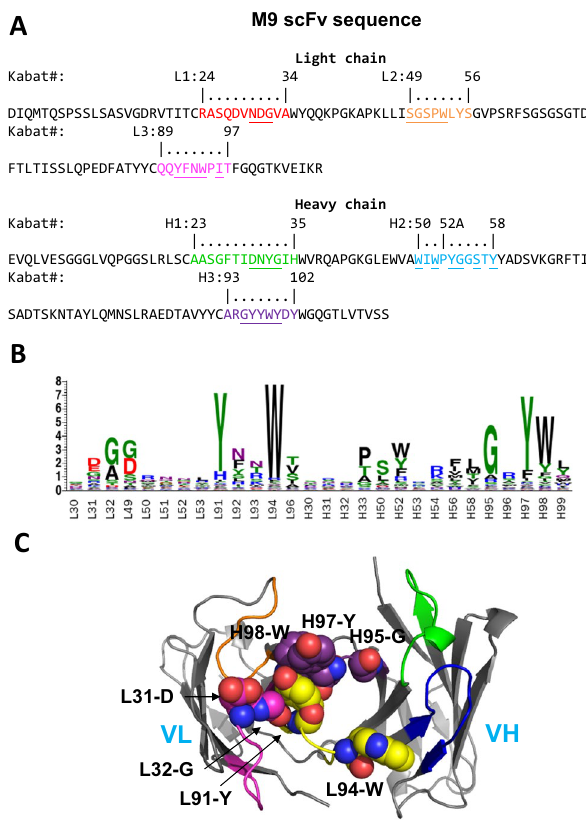
Figure 2. Amino acid sequences of the anti-MSLN M9 antibody variable domains and MSLN-positive scFv CDR-variants of M9 selected from the phage-displayed synthetic antibody libraries based on the methodology depicted in Fig. 1. ( A ) Sequences of the M9 light chain and heavy chain variable domain are labeled with Kabat numbering. The colored regions are the CDRs defined by North et al. 34 . Underlined CDR residues were diversified with degenerated codon NNK in constructing the phage-displayed synthetic antibody libraries in Step 1 of Fig. 1. ( B ) The panel shows the sequence LOGO of the scFv CDR-variants of M9 from Step 6 of the procedure shown in Fig. 1. The scFv CDR-variant sequences are listed in Supplementary Table S1. ( C ) The M9 light chain and heavy chain scFv VL/VH variable domain structures were computationally modelled with RosettaAntibody modeling software 35 with default parameters. Amino acid residues in van der Waals spheres are labeled according to the Kabat numbering as shown in panel ( A ). The CDR loops are colored in red, orange, yellow, green, blue and purple for L1, L2, L3, H1, H2 and H3 respectively. The secondary structures of the M9 scFv are shown by grey arrow ribbon connected with cylindrical